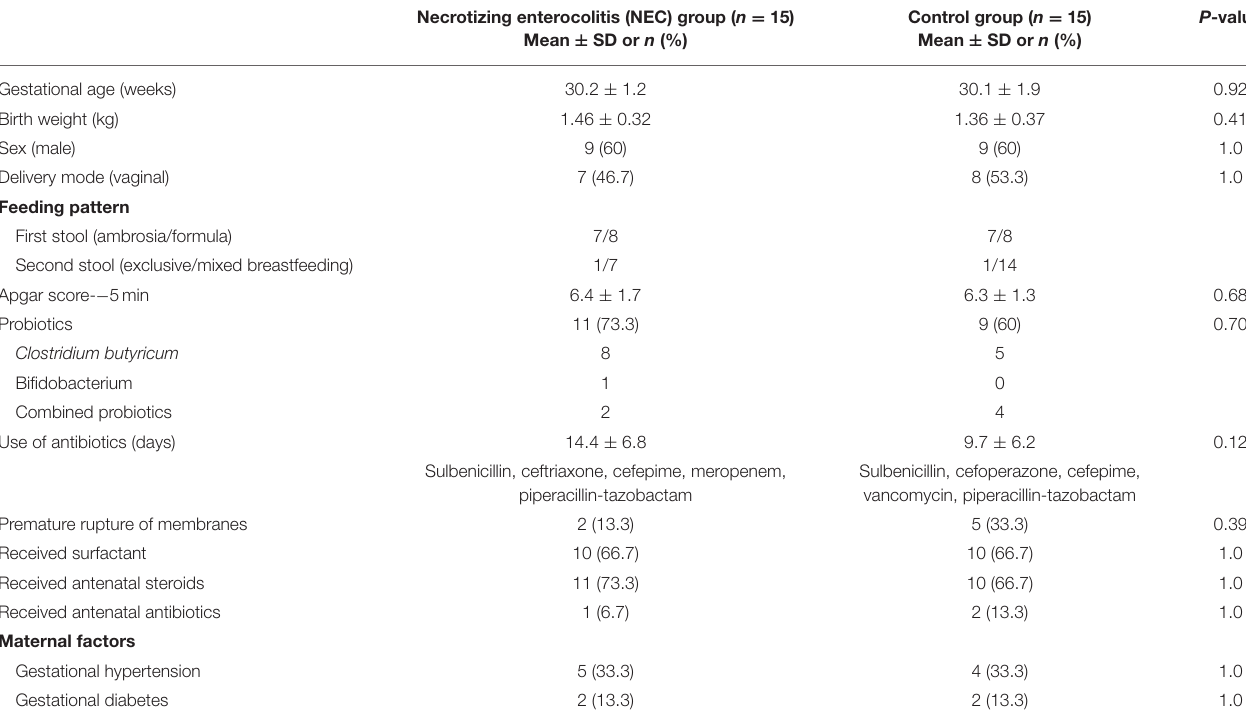
TABLE 1 | Infant characteristics and clinical